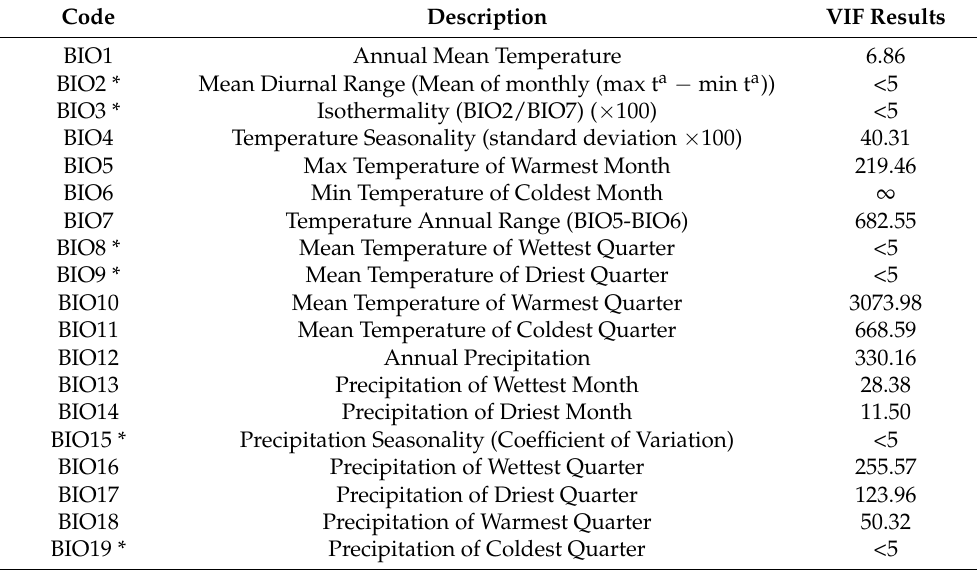
Table 1. Bioclimatic variables selected in the variance inflation factors (VIF) analysis (*) from the 19 variables available on WorldClim